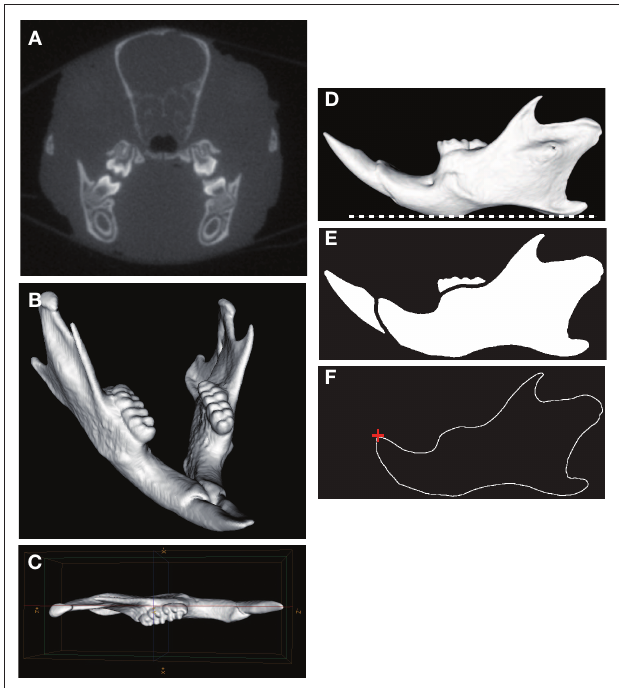
Figure 1 | Micro-CT scanning and image processing of the mouse mandible. Transverse micro-CT slice of the craniofacial skeleton (A) . Three- dimensional reconstruction of the whole mandible (B) . The left hemimandible appeared as a relatively plane structure and was aligned parallel with the sagittal plane (C) . Horizontal orientation of the mandibular plane (dashed white line) (D) . Binarized image and segmentation of the mandibular bone (e) . Extraction of the mandibular outline (F) ; the starting point of the outline (red cross) corresponded to the anterodorsal tip of the incisor